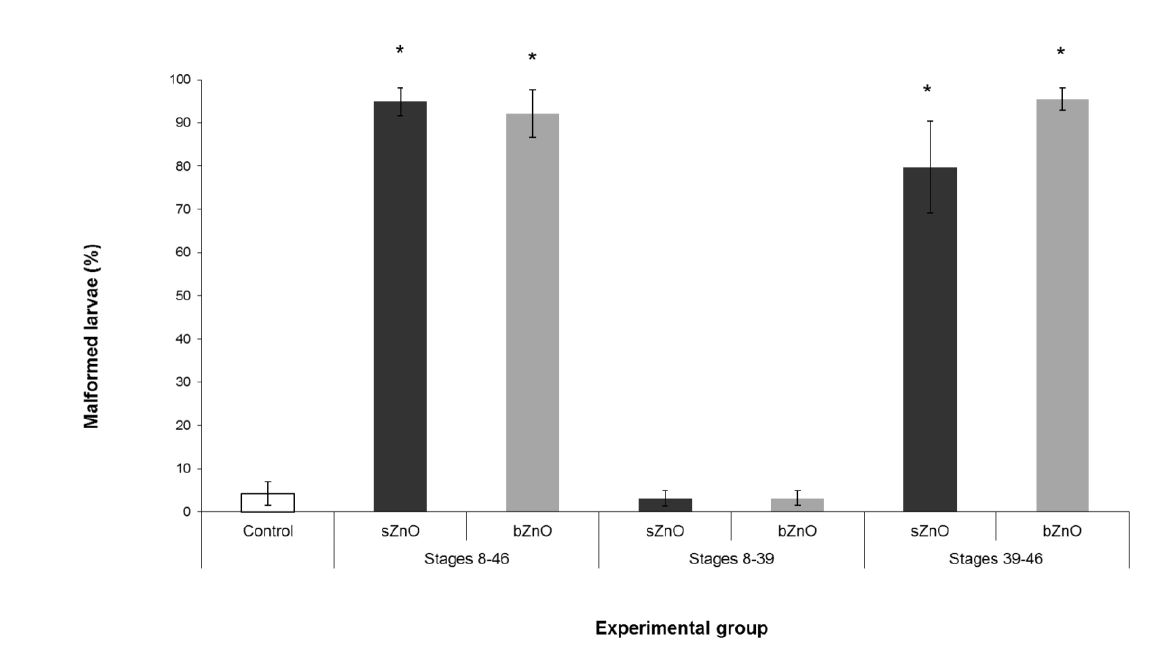
Figure 5. Percentages of malformed embryos after exposure to sZnO and bZnO at 50 mg/L in different developmental windows. Dark grey = sZnO-exposed larvae; light grey = bZnO-exposed larvae. Stages 8–46, exposure during the whole embryogenesis as in the FETAX protocol; Stages 8–39, exposure from blastula to the stomodeum opening (two days 8 hpf); Stages 39–46, exposure from stomodeum opening to the end of the primary organogenesis. * Statistically different from control at p < 0.001, ANOVA + Fisher LSD